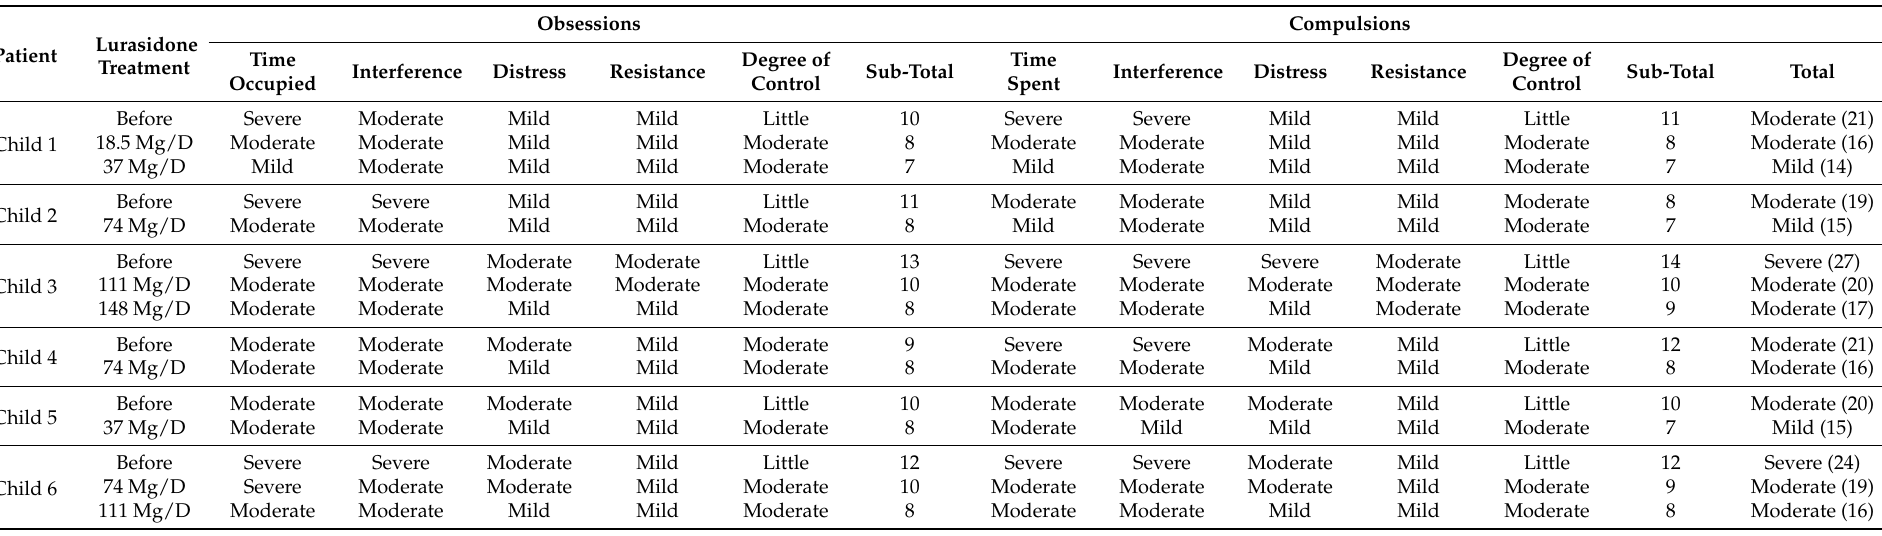
Table 4. Children’s Yale–Brown Obsessive Compulsive Scale (CY-BOCS Symptom